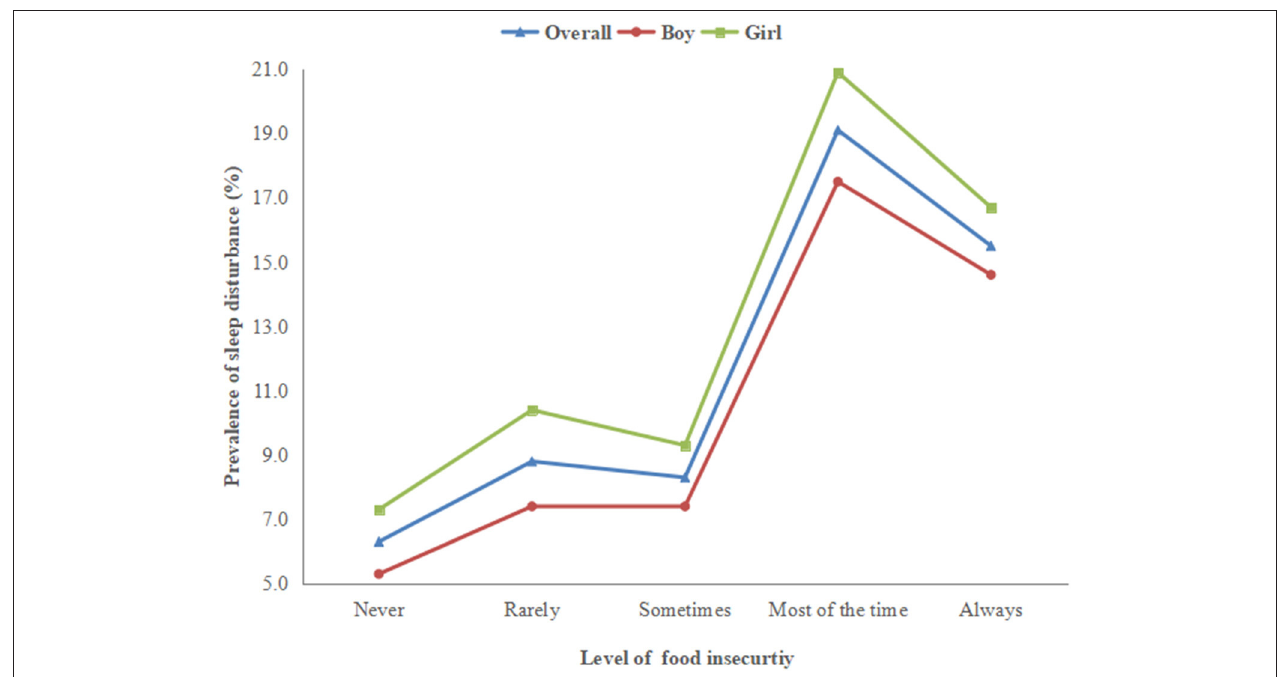
FIGURE 1 | Prevalence of sleep disturbance by levels of food insecurity.